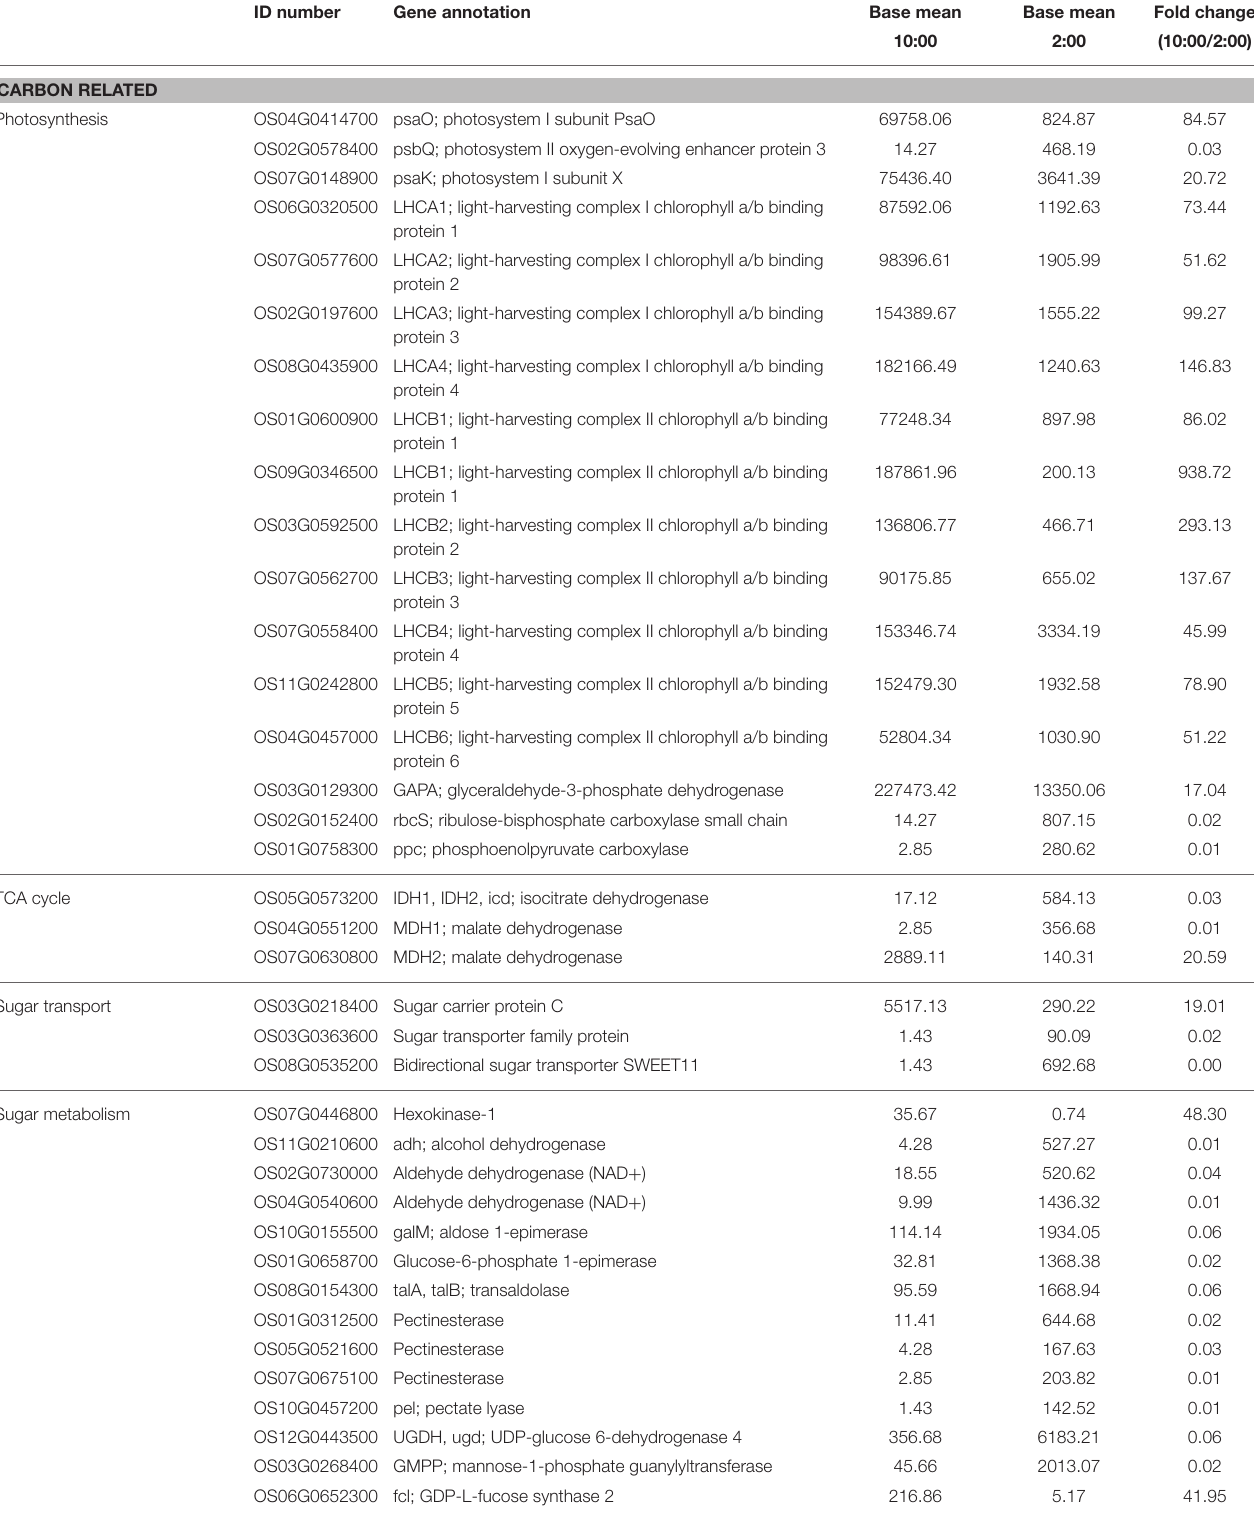
TABLE 2 | Differentially expressed genes involved in carbon and nitrogen metabolism at the time of 10:00 compared to